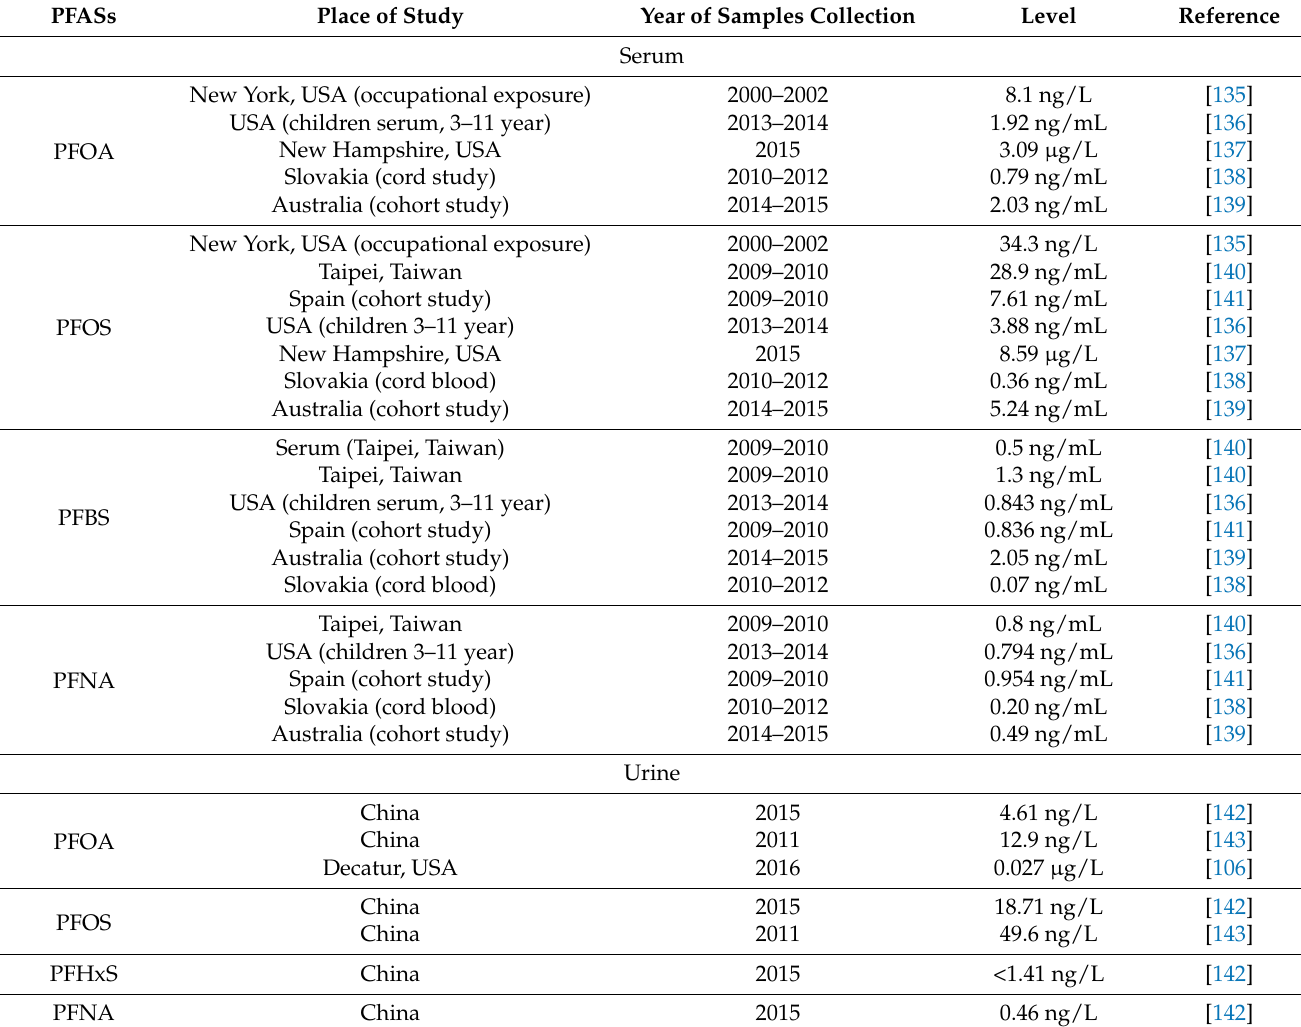
Table 5. Occurrence of selected PFASs in human serum and